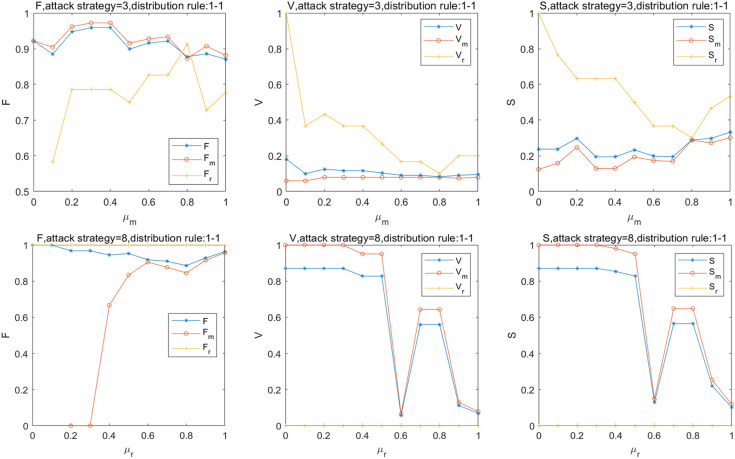
Effect of μm & μr on robustness of the SRN.